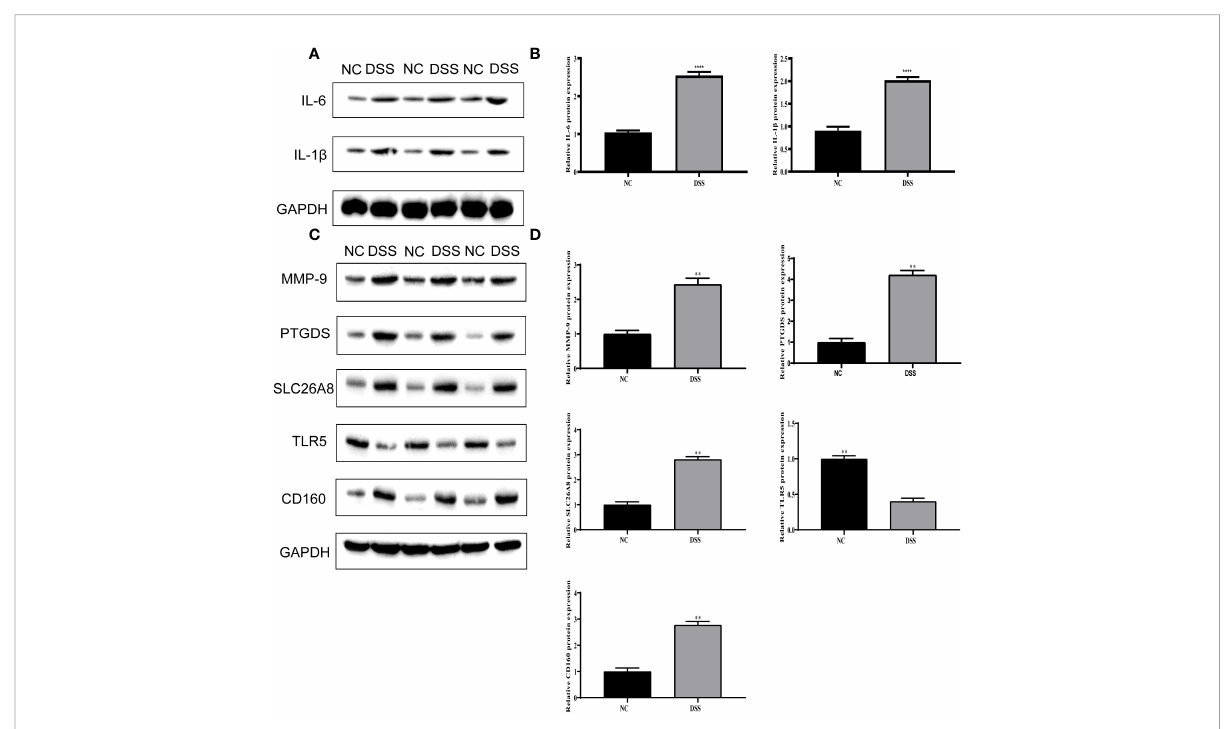
FIGURE 11 Validation of differential expression of in fl ammatory factors and fi ve biomarkers. (A) Protein expression of IL-6 and IL-1 b . (B) Protein statistics of IL-6 and IL-1 b . (C) Protein expression of fi ve biomarkers. (D) Protein statistics of fi ve biomarkers. ** P < 0.01, **** P < 0.0001.